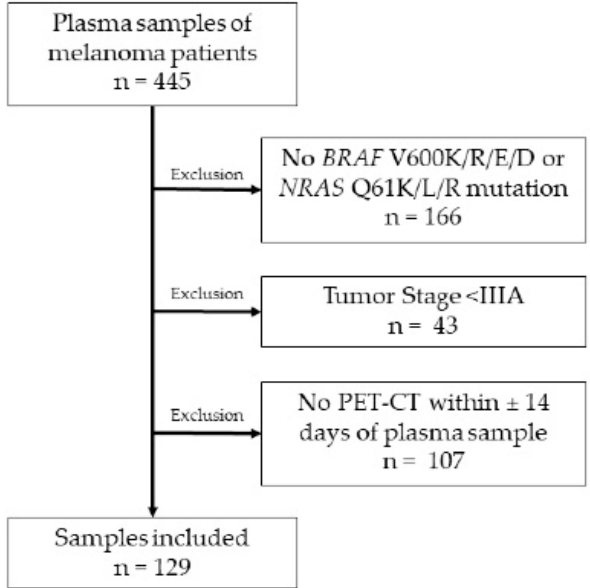
Figure 1. Overview of sample selection.